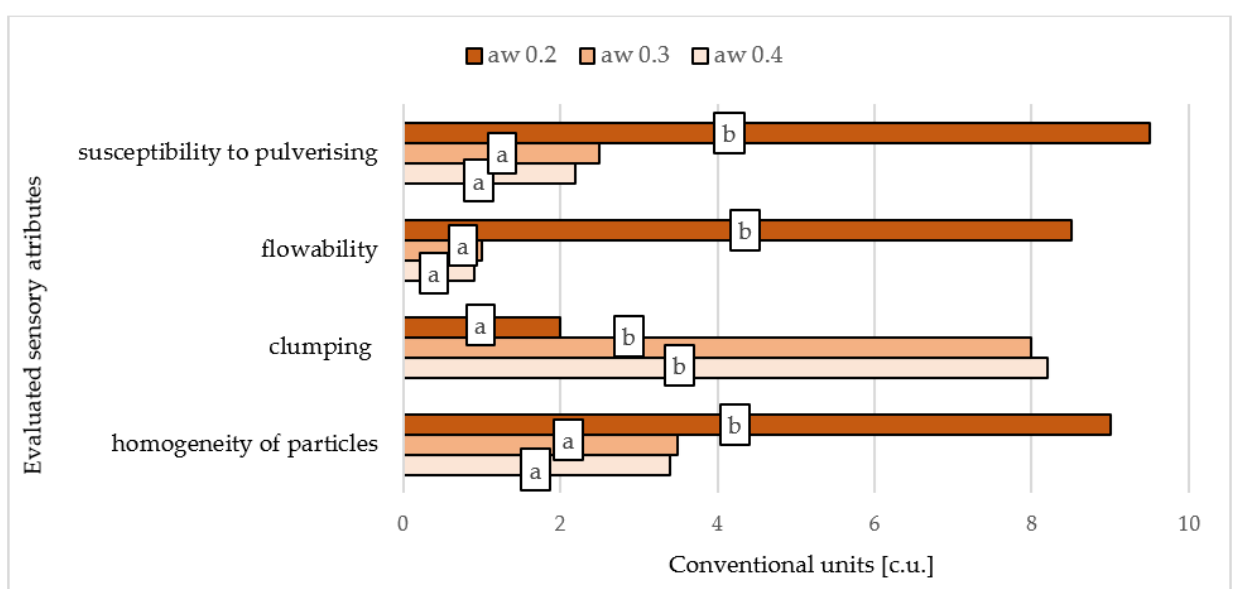
Figure 2. Sensory characteristics of the dried chokeberry using convection drying to different water activity (a w ), subjected then to milling process. Values are means ± standard deviation. a,b—different letters in the same line are significantly different (Duncan’s test, p < 0.05).